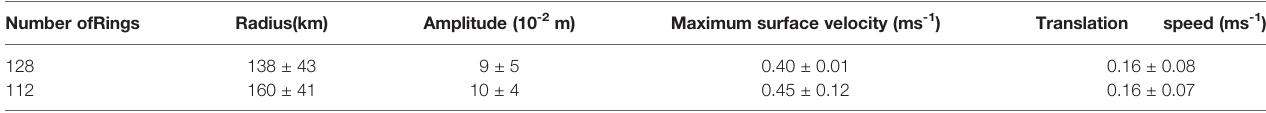
TABLE 2 | Mean NBC ring properties derived from the META dataset: radius of maximum surface geostrophic velocities (km), amplitude (10 -2 m), maximum surface velocity and translation speed (ms -1 ), estimated for all 128 rings identi fi ed in the META dataset, and for the 112 rings that were sampled at least once by T and/or S pro fi les. Number ofRings